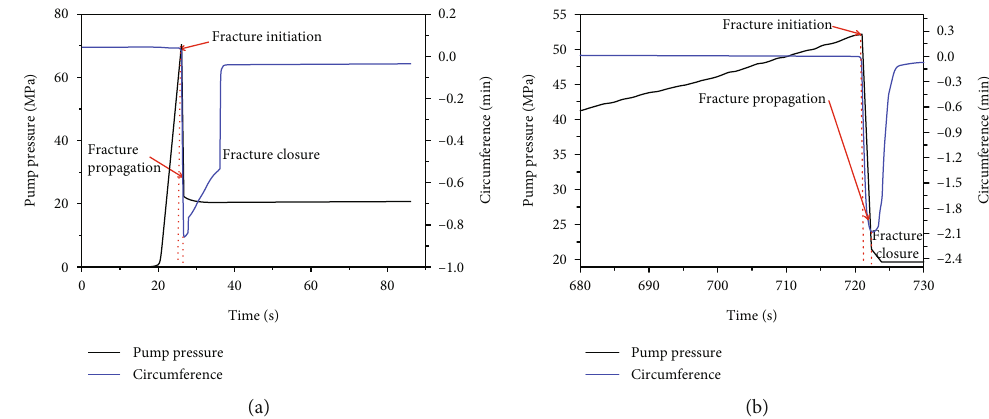
Figure 8: Curves of hydraulic fracturing using (a) water and (b) SC-CO of shale with bedding plane angle of 0 ° under axial stress 25 MPa, 2 con fi ning pressure 20 MPa, and injection rate 0.3ml/s. (The fracture width evolution was calculated. The maximum fracture width was calculated by the circumference di ff erence from fracture initiation to the valley. The opening fracture width during the equilibrium state was by circumference di ff erence from fracture initiation to the stable. The closure of the fracture was by circumference di ff erence from fracture stable to the valley.)